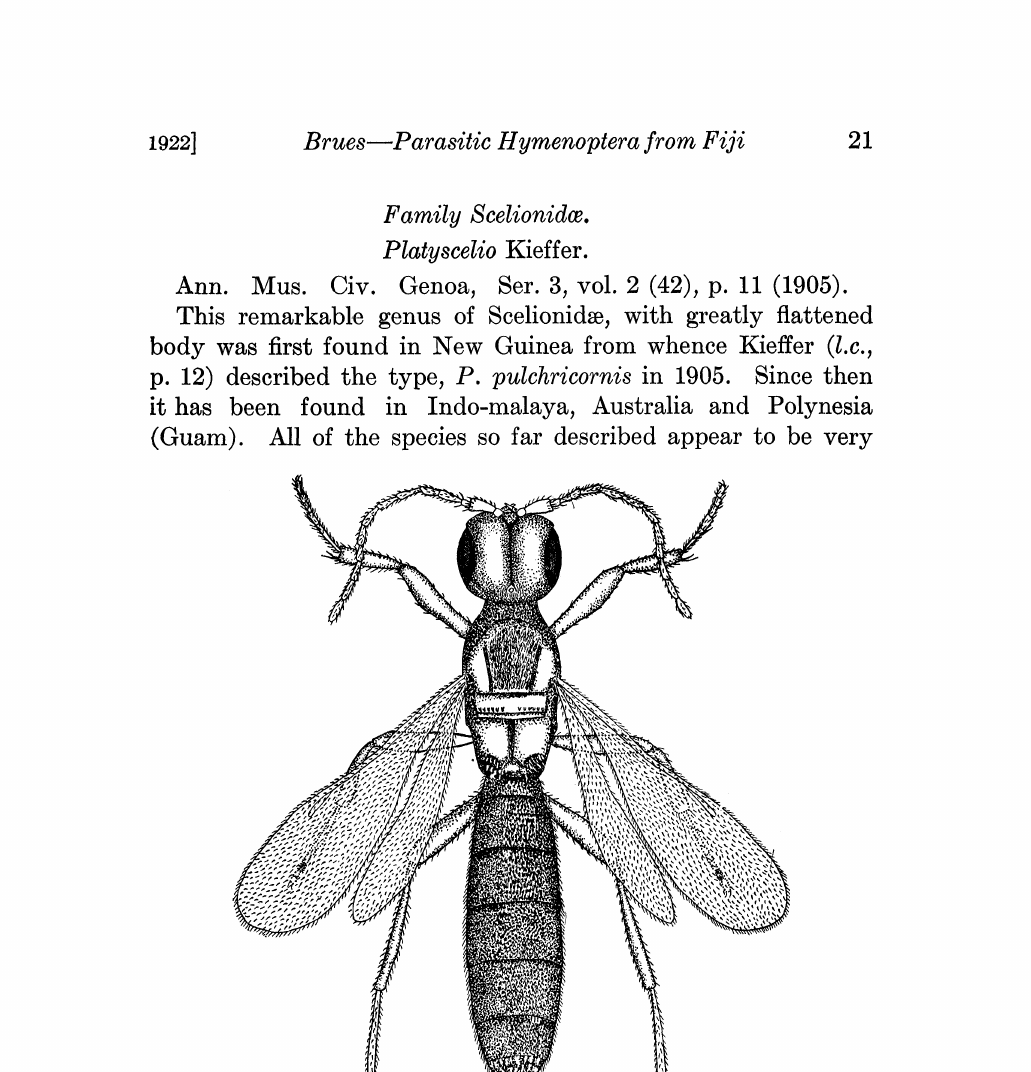
Fig. 2. Platyscelio